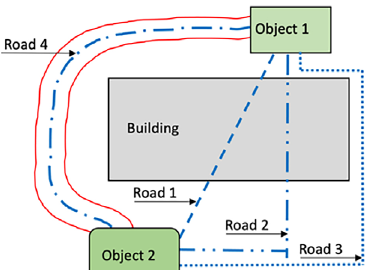
Figure 1. Modeling and measuring the distance of access roads between